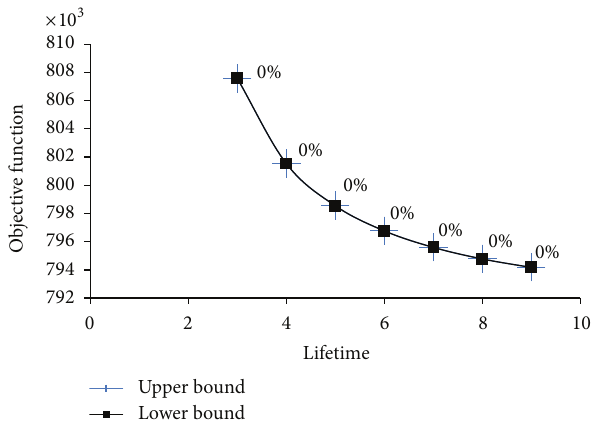
Figure 4: Sensitivity of objective function to changes in the lifetime for 15-node data set.